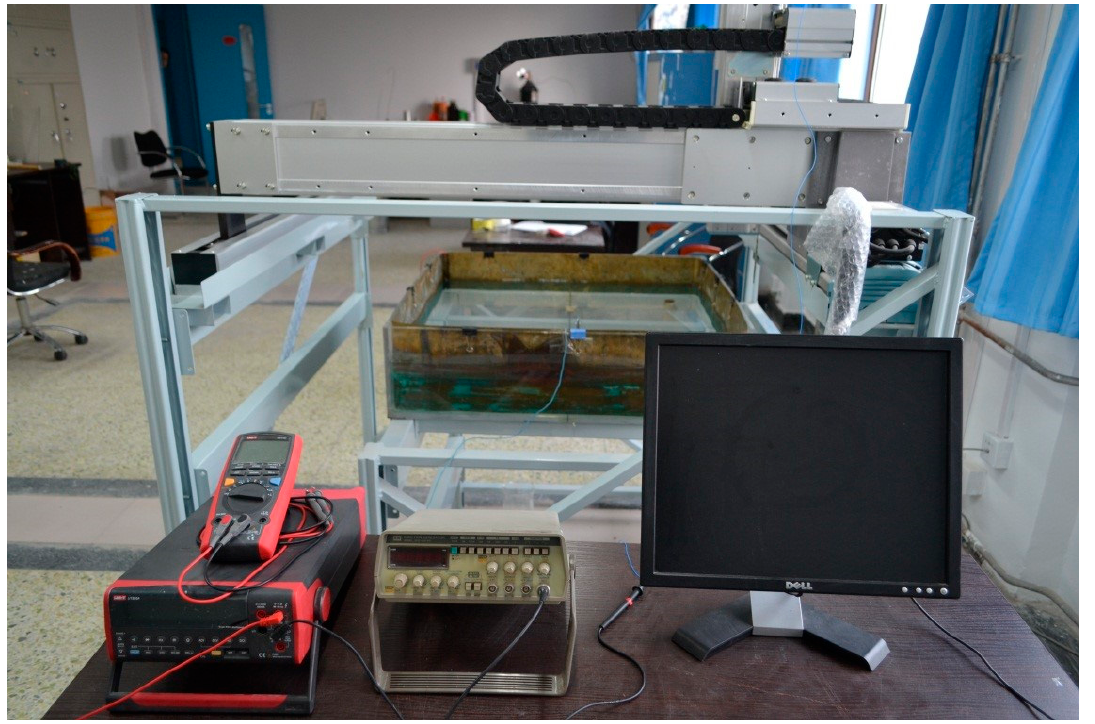
Figure 6. Physical diagram of electric simulation experiment.